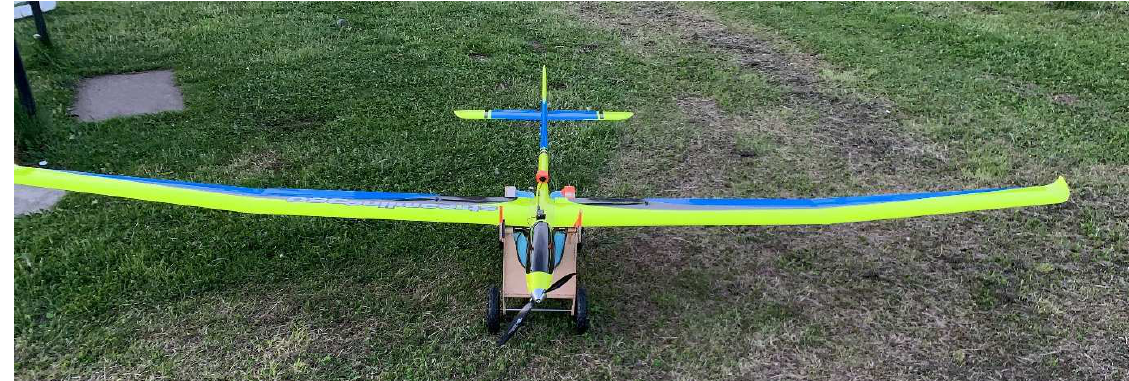
Figure 1. The Streamliner 350 aircraft single “16 × 10” propeller at the front of the fuselage.